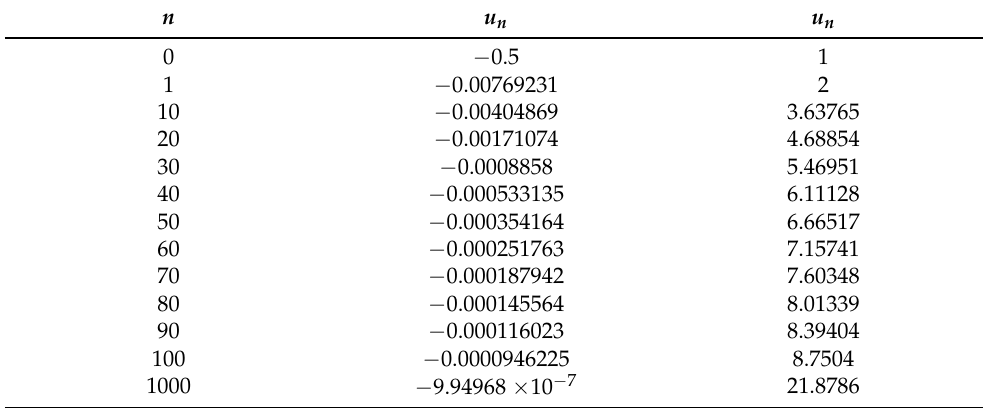
Table 1. Comparing 1000 iterations u n with different initial